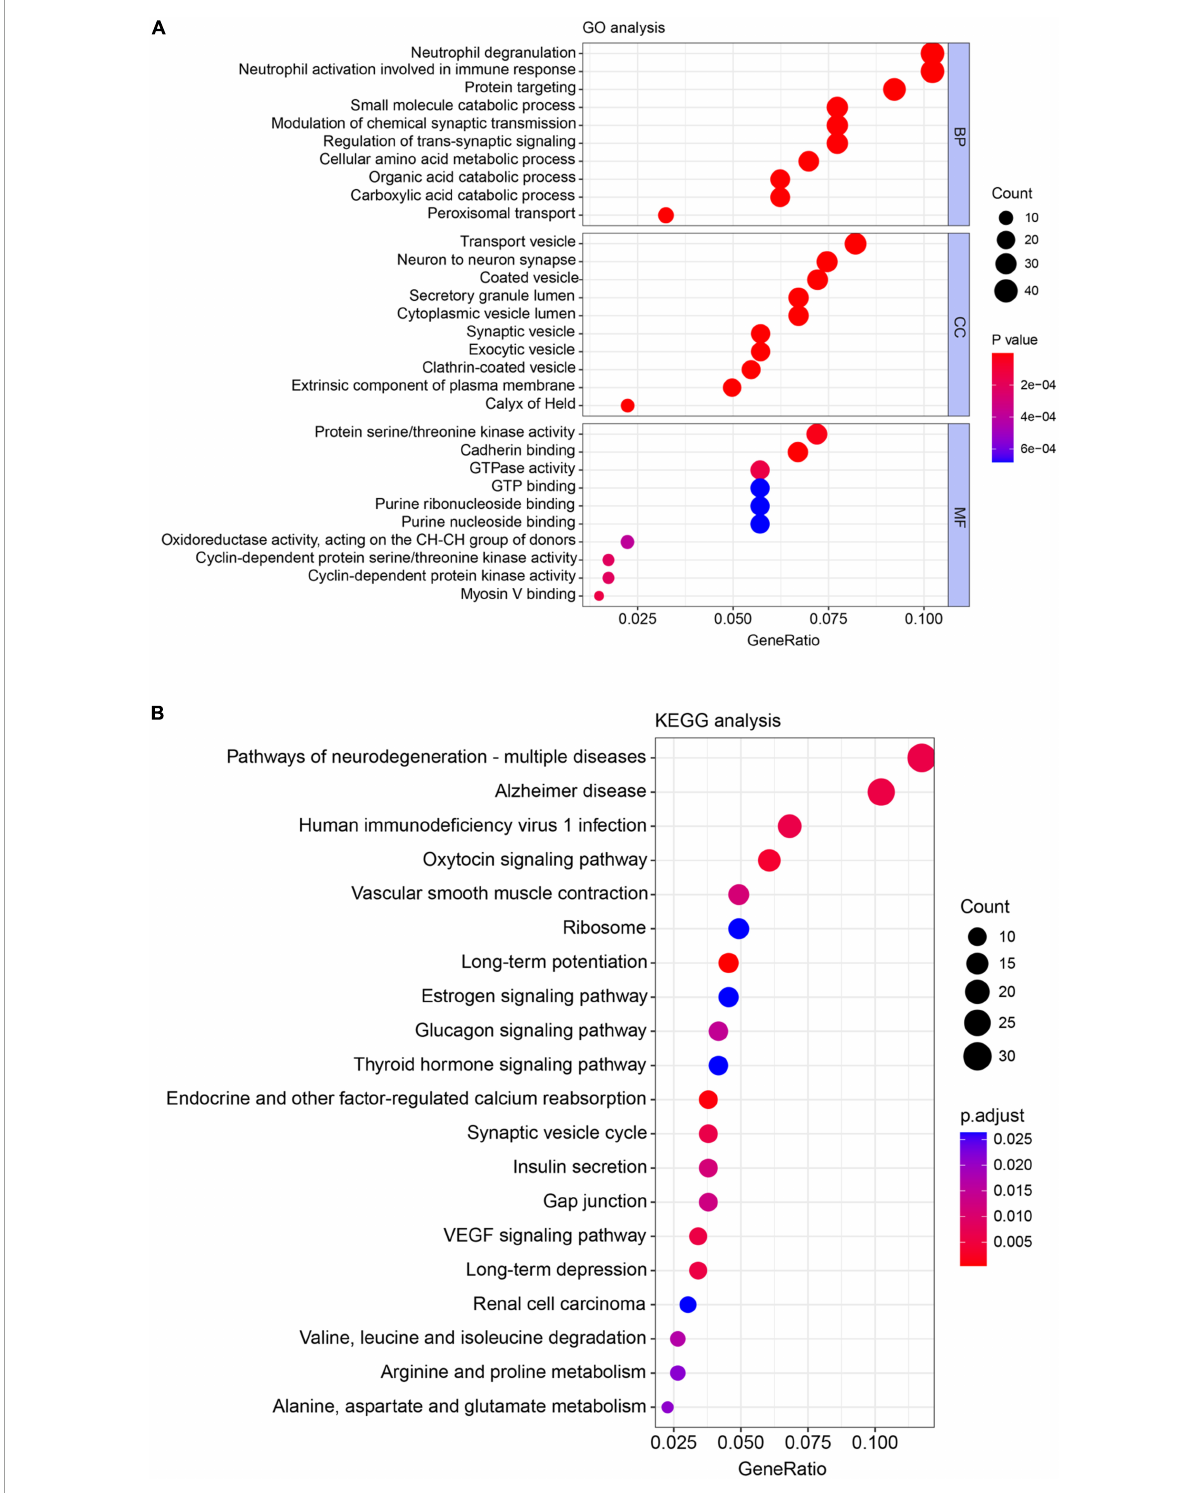
FIGURE3 Gene ontology (GO) annotation and kyoto encyclopedia of genes and genomes (KEGG) pathway enrichment analysis of differentially expressed proteins extracted from the spinal cord. (A) GO analysis of the biological process (BP), cellular component (CC), and molecular function (MF) for differentially expressed proteins (DEPs). (B) KEGG analysis of DEPs. Count: number of DEPs related to the enriched GO or KEGG terms. Different colors indicated the range of p-